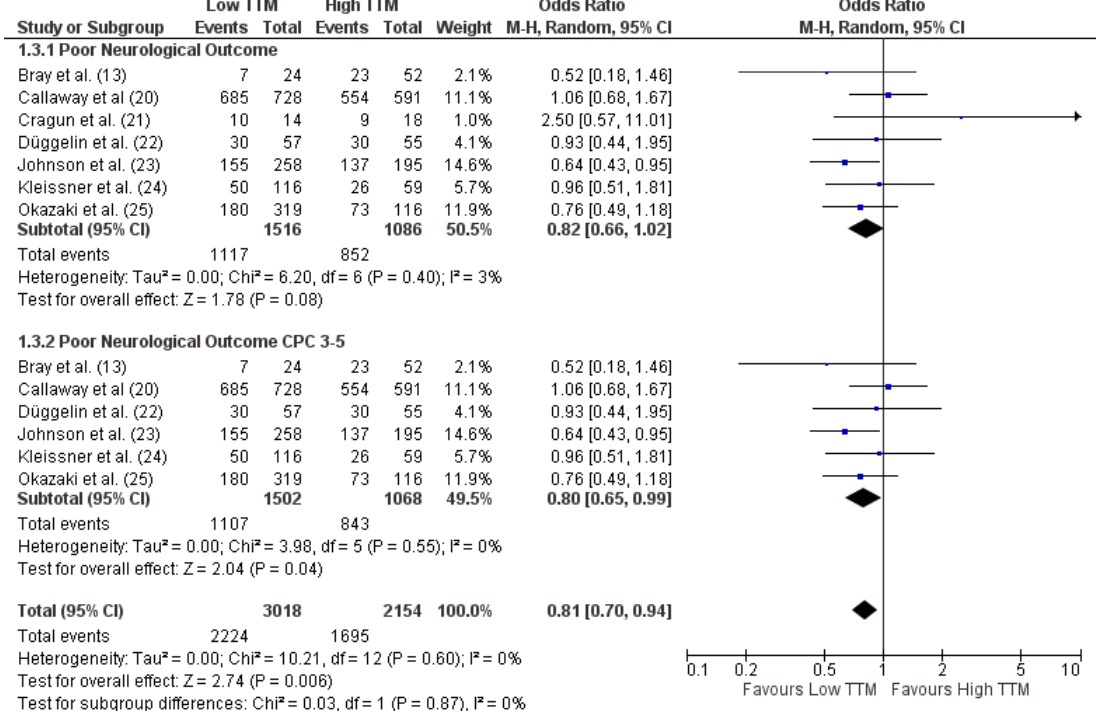
Figure 2. Forest plot for unfavorable neurological outcome in all patients with reported outcome and in all those with reported CPC 3–5. Low TTM = TTM at 33 °C; High TTM = TTM at 36 °C. The size of the squares for the risk ratio reflects the weight of the trial in the pooled analysis. The horizontal bars represent 95% confidence intervals (CIs) [13,20–25].